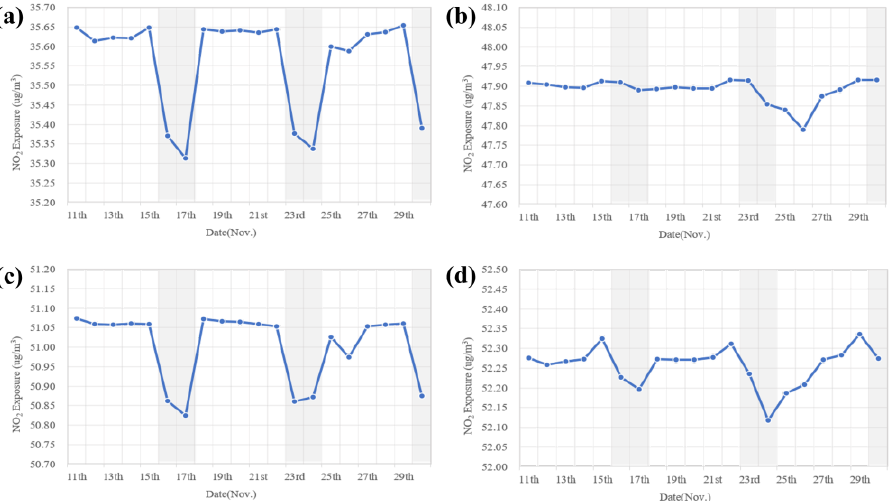
Figure 4. Daily NO 2 exposure during ( a ) daytime (9 a.m. – 5 p.m.), ( b ) nighttime (7 p.m. – 7 a.m.), ( c ) morning peak (7 a.m. – 9 a.m.), and ( d ) evening peak (5 p.m. – 7 p.m.) in